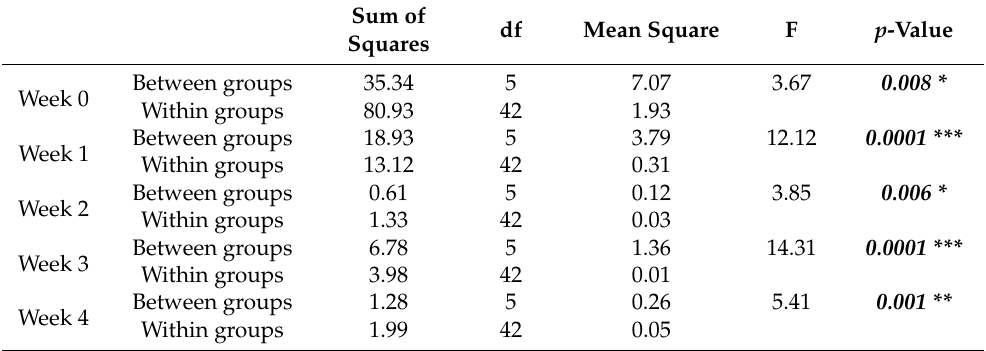
Table 4. MEP comparison using one-way ANOVA with group factor ( n = 24).